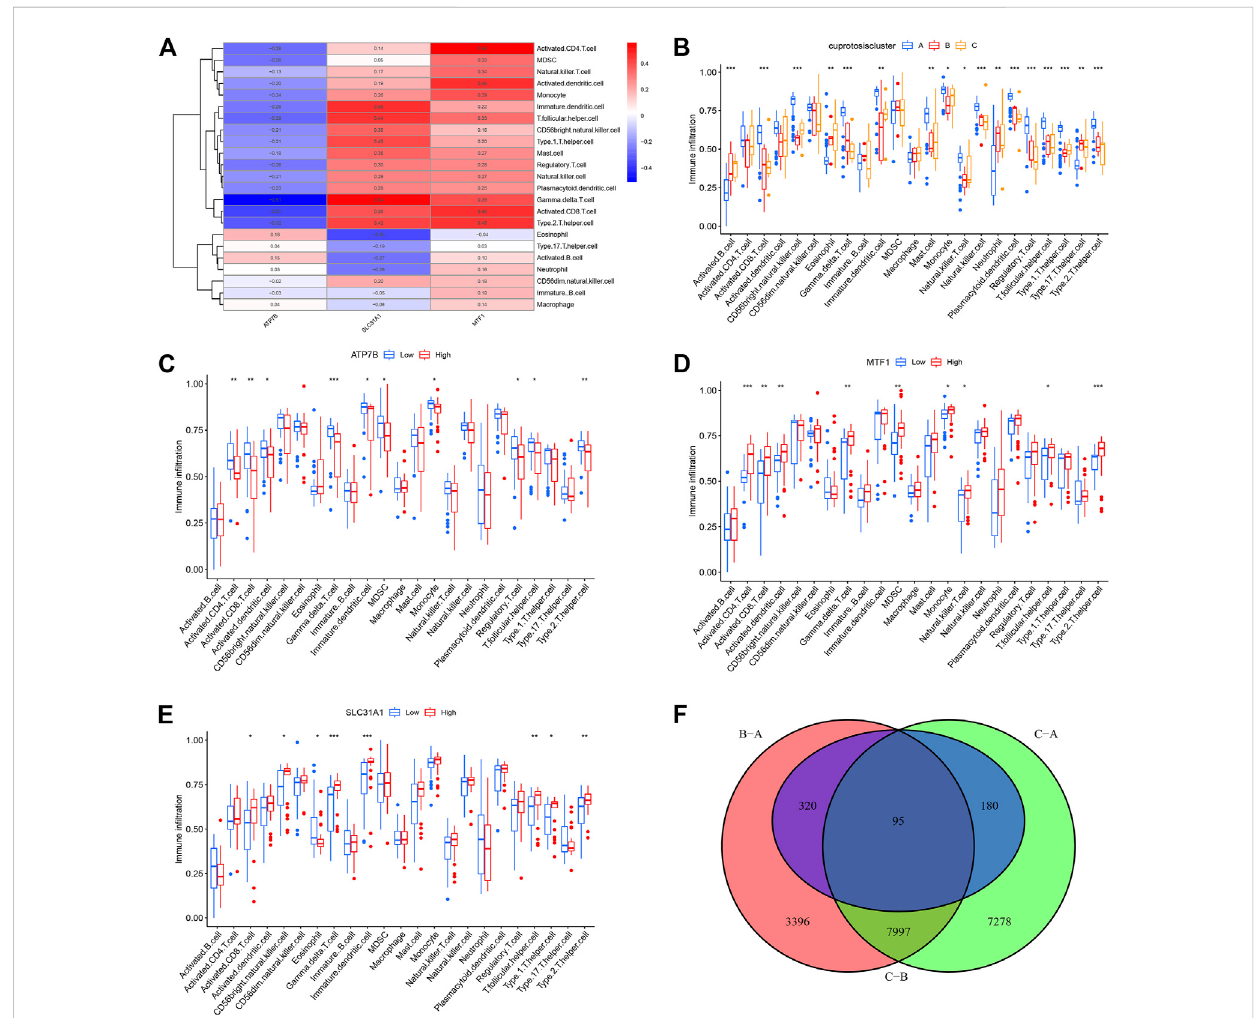
FIGURE 6 Single sample gene set enrichment analysis. (A) Correlation between in fi ltrating immune cells and the 3 signi fi cant cuproptosis regulators. (B) Differential immune cell in fi ltration between clusterA, clusterB and clusterC. (C – E) Difference in the abundance of in fi ltrating immune cells between high and low ATP7B, MTF1andSCL31A1expressiongroups. (F) Theintersectionofcopperdeathdifferentialgenesinthreecopperdeathtypes.* p < 0.05,** p < 0.01,and*** p <